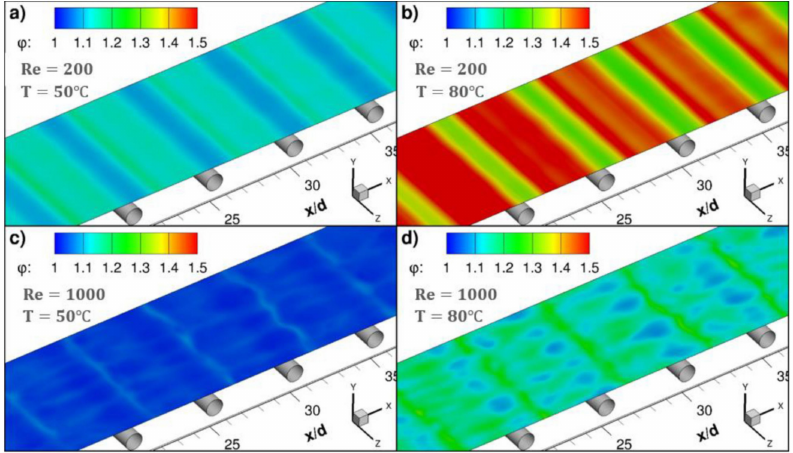
Figure 12. Instantaneous contours of the concentration polarization coefficient, ϕ , on the top mem- brane surface at a non-dimensional time τ i with the addition of filaments [17]. Reproduced with permission from Elsevier, 2019. ( a ) Re = 200, T = 50 ◦ C; ( b ) Re = 200, T = 80 ◦ C; ( c ) Re = 1000, T = 50 ◦ C; ( d ) Re = 1000, T = 80 ◦